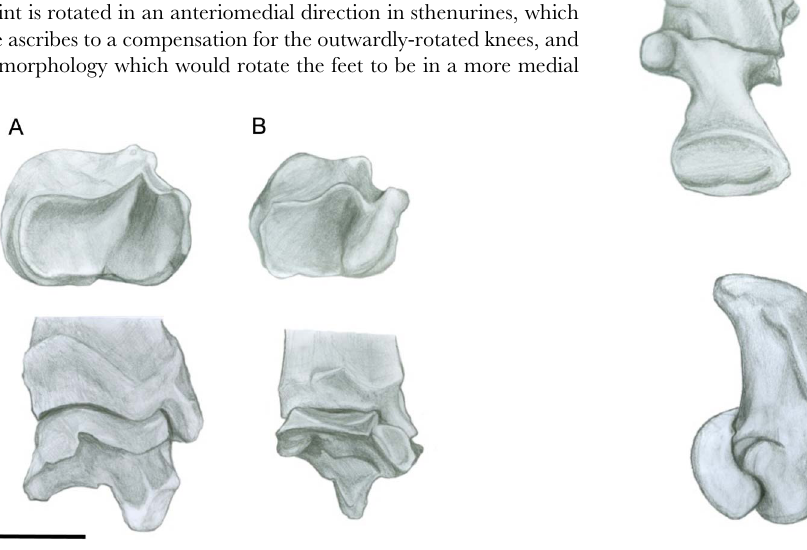
Figure 6. Astragalus and calcaneum. (A) Simosthenurus occidentalis (SAM: P17258 [reversed]). (B) Macropus giganteus (SAM: P17523 [reversed]). All left side: upper = proximodorsal view; lower = lateral view. Scale bar =2 cm.